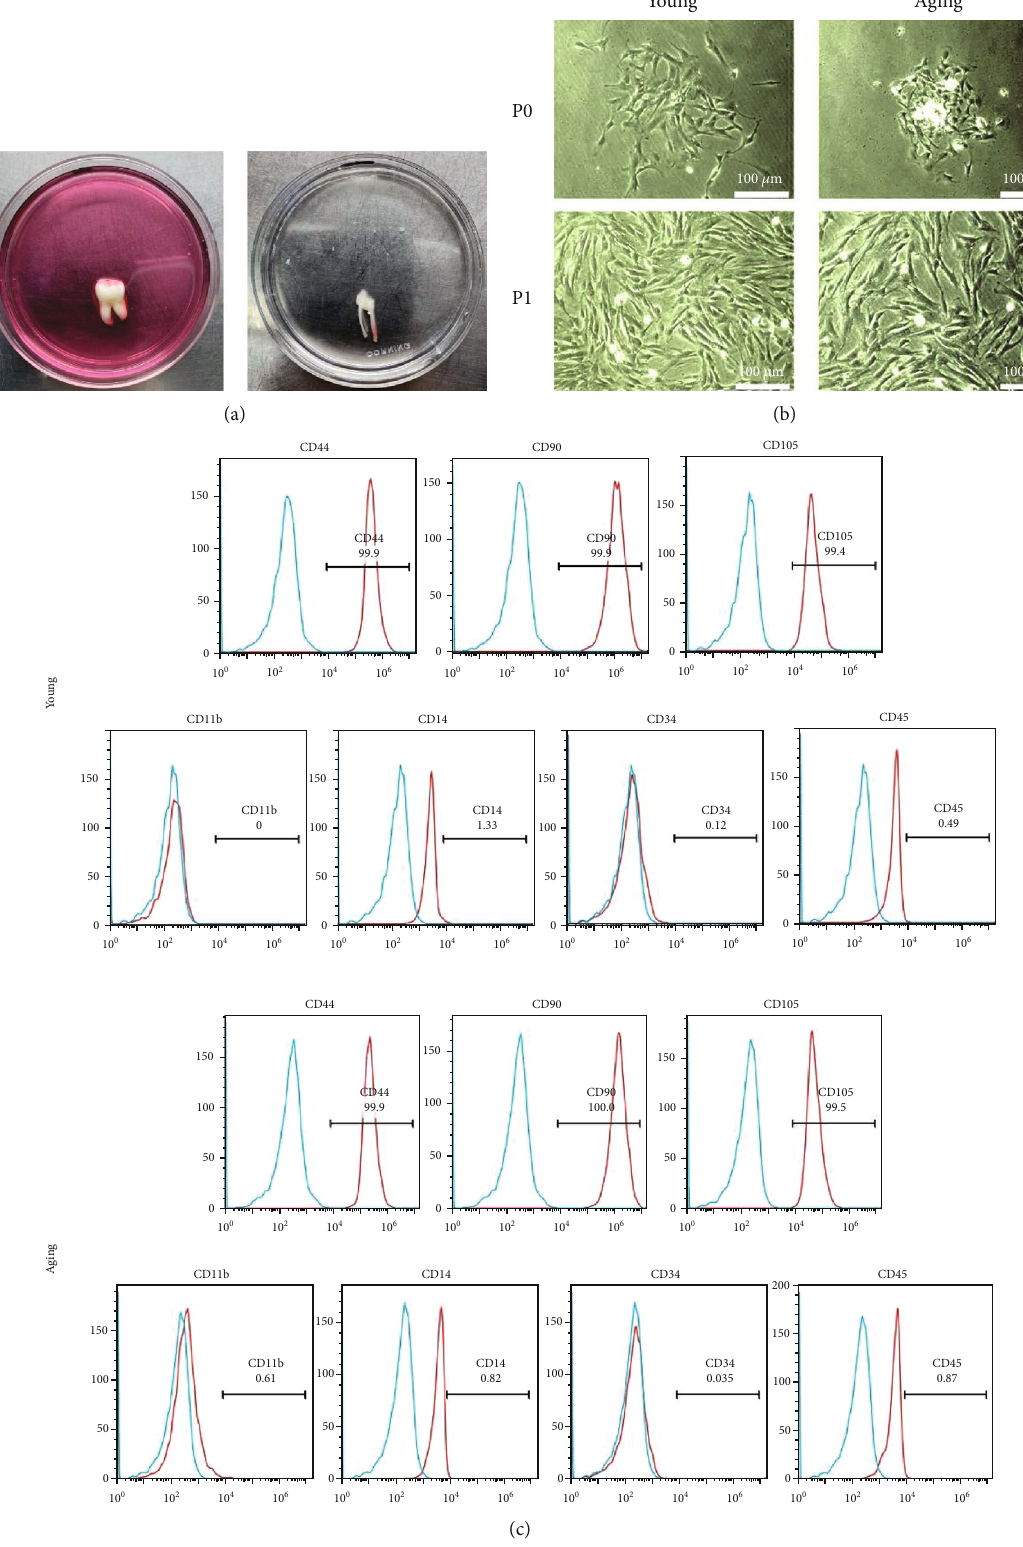
Figure 1: Isolation, culture, and identi fi cation of DPSCs. (a) The human pulp tissues were obtained from freshly extracted teeth. (b) Young and aging DPSCs were observed at P0 and P1 using an optical microscope (magni fi cation, × 100). (c) Surface marker pro fi ling of young and aging DPSCs was evaluated by fl ow